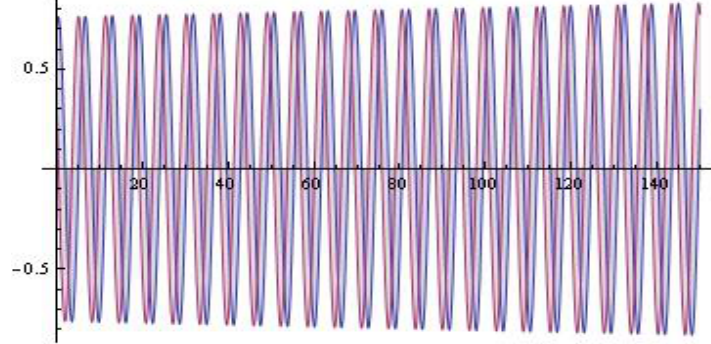
Figure 3. The system solutions ( (cid:101) = 0.001; n = 5).